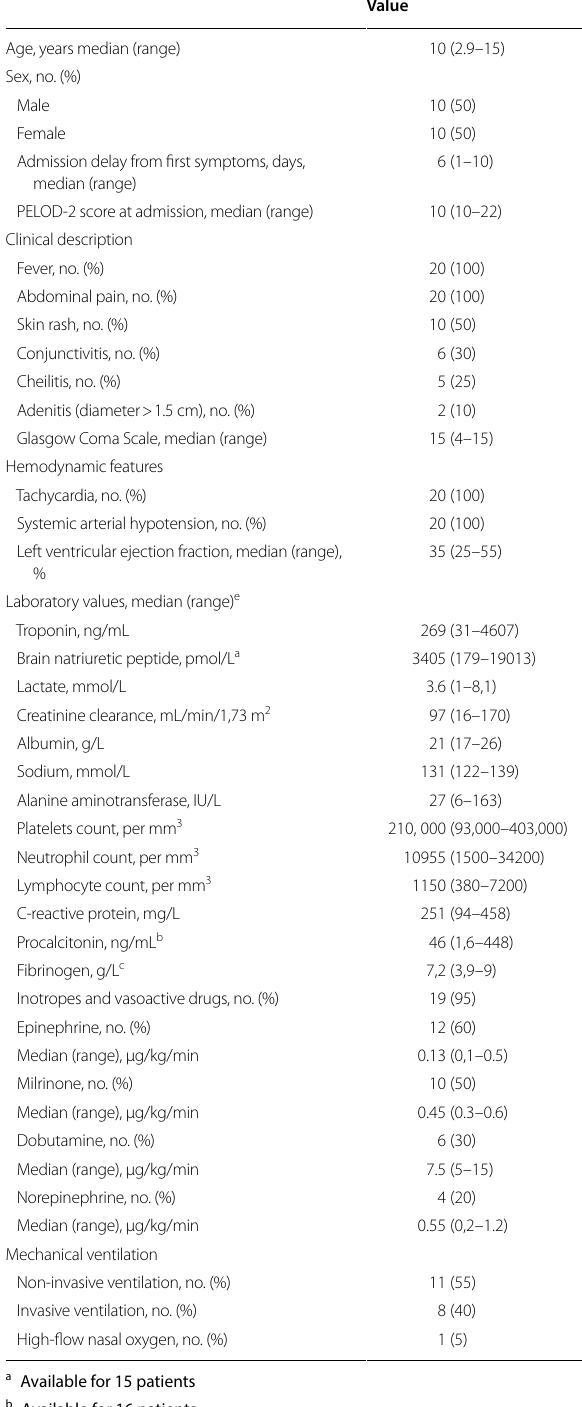
Table 1 Clinical, biological and hemodynamic